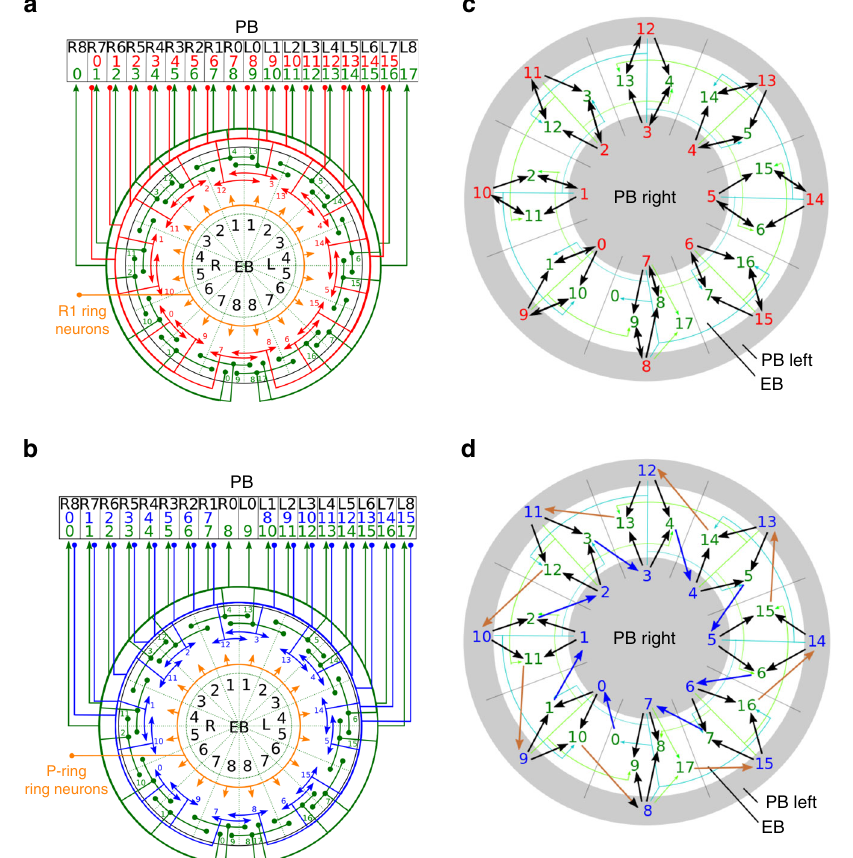
Fig. 2 The circuit structures of the C and P rings. a The C-ring and b the P-ring circuits represented by the neuronal innervation reconstructed based on data from recent anatomical studies 32, 33 . The EIP, PEI, PEN, and ring-neuron classes are represented by green , red , blue and orange lines , respectively. Arrowheads indicate the axonal terminals, while solid circles i ndicate the dendritic terminals. The numbers denote the neuron types for each color-matched neuron class. The black numbers label the regions in each neuropil. c The C-ring and d the P-ring circuits in a representation depicting both neuron connections and innervation regions. To visually emphasize the excitatory feedback circuits, the ring neurons are not included. The outer and inner circles represent the left and right sides of PB, respectively, while the middle ring is for the EB. Each neuron (as indicated by its color and type number, same as in a and b ) is placed in its main dendritic innervation region. Arrows indicate the connections between neurons, with the thickness qualitatively representing the synaptic strength. The arrows are colored for the visualization purpose. The C-ring circuit is mainly constructed by symmetric feedback connections, while the P-ring circuit is characterized by asymmetric connections, which can be separated into a clockwise ( blue arrows ) and a counterclockwise ( brown arrows )